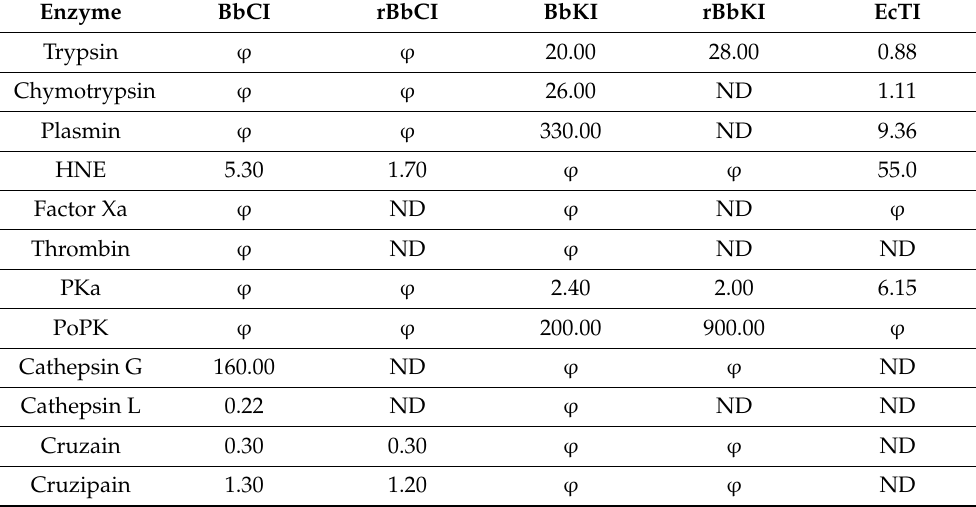
Table 1. Inhibitory properties of BbCI, rBbCI, BbKI, rBbKI, and EcTI (K iapp values are shown in nM).